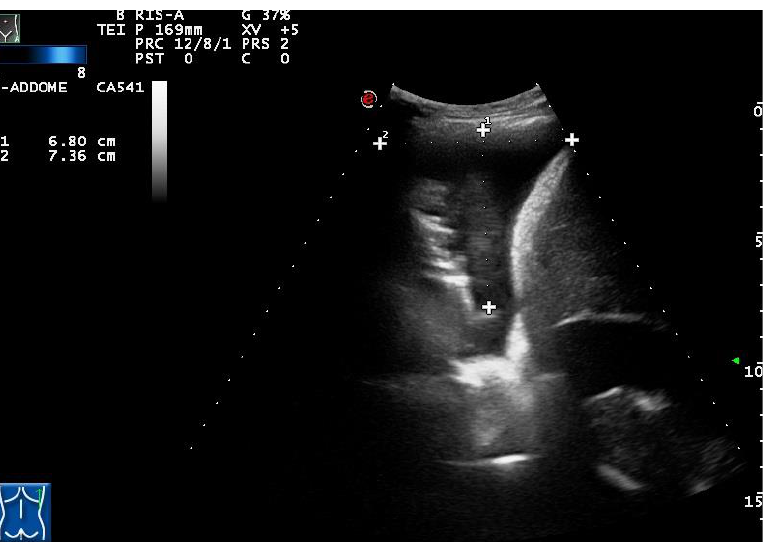
Figure 3. A complex nonseptated pleural exudate in a patient with pneumonia, measured by two orthogonal views (longitudinal and transversal), viewed by longitudinal scan using a convex multifrequency probe (3.5 MHz).